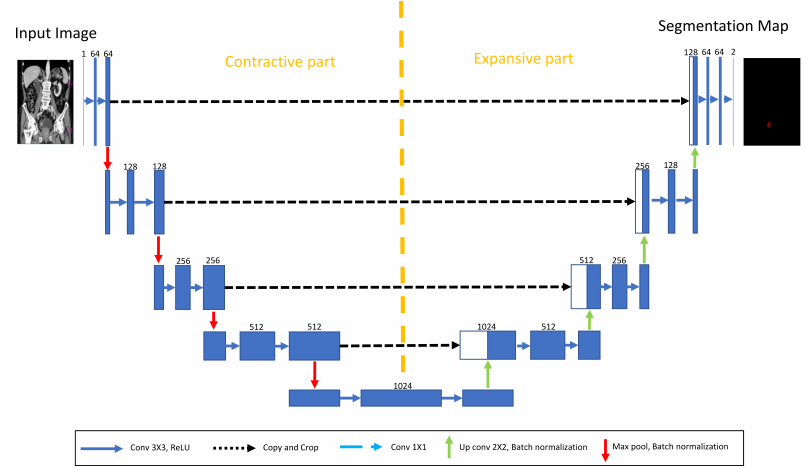
Figure 4. A block scheme of the proposed U-net architecture.